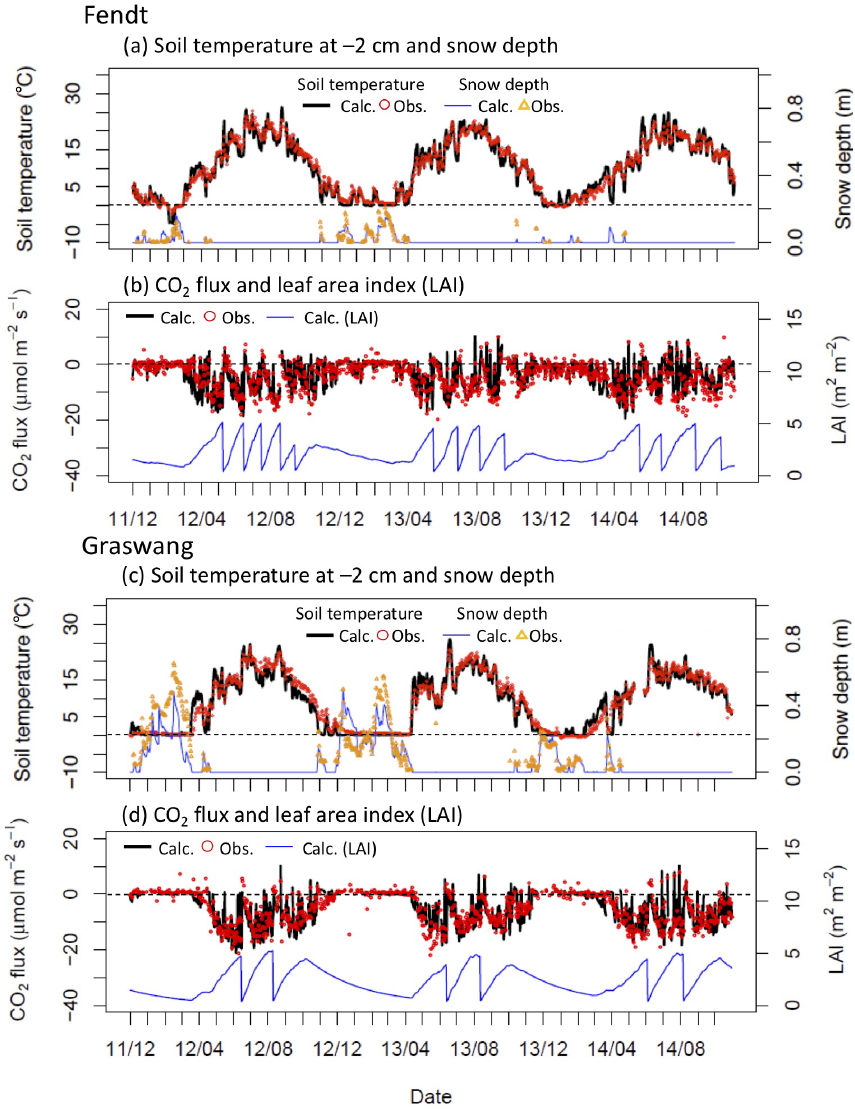
Figure 2. Time series for calculated (solid lines) and observed (open symbols) (a, c) daily mean soil temperature at a depth of 0.02m and snow depth and (b, d) CO 2 flux ( F CO ) and leaf area index (LAI) at (a–d) Fendt and (e–h) Graswang throughout the study period. Sudden 2 decreases in calculated LAI in (b, d) represent grass-cutting